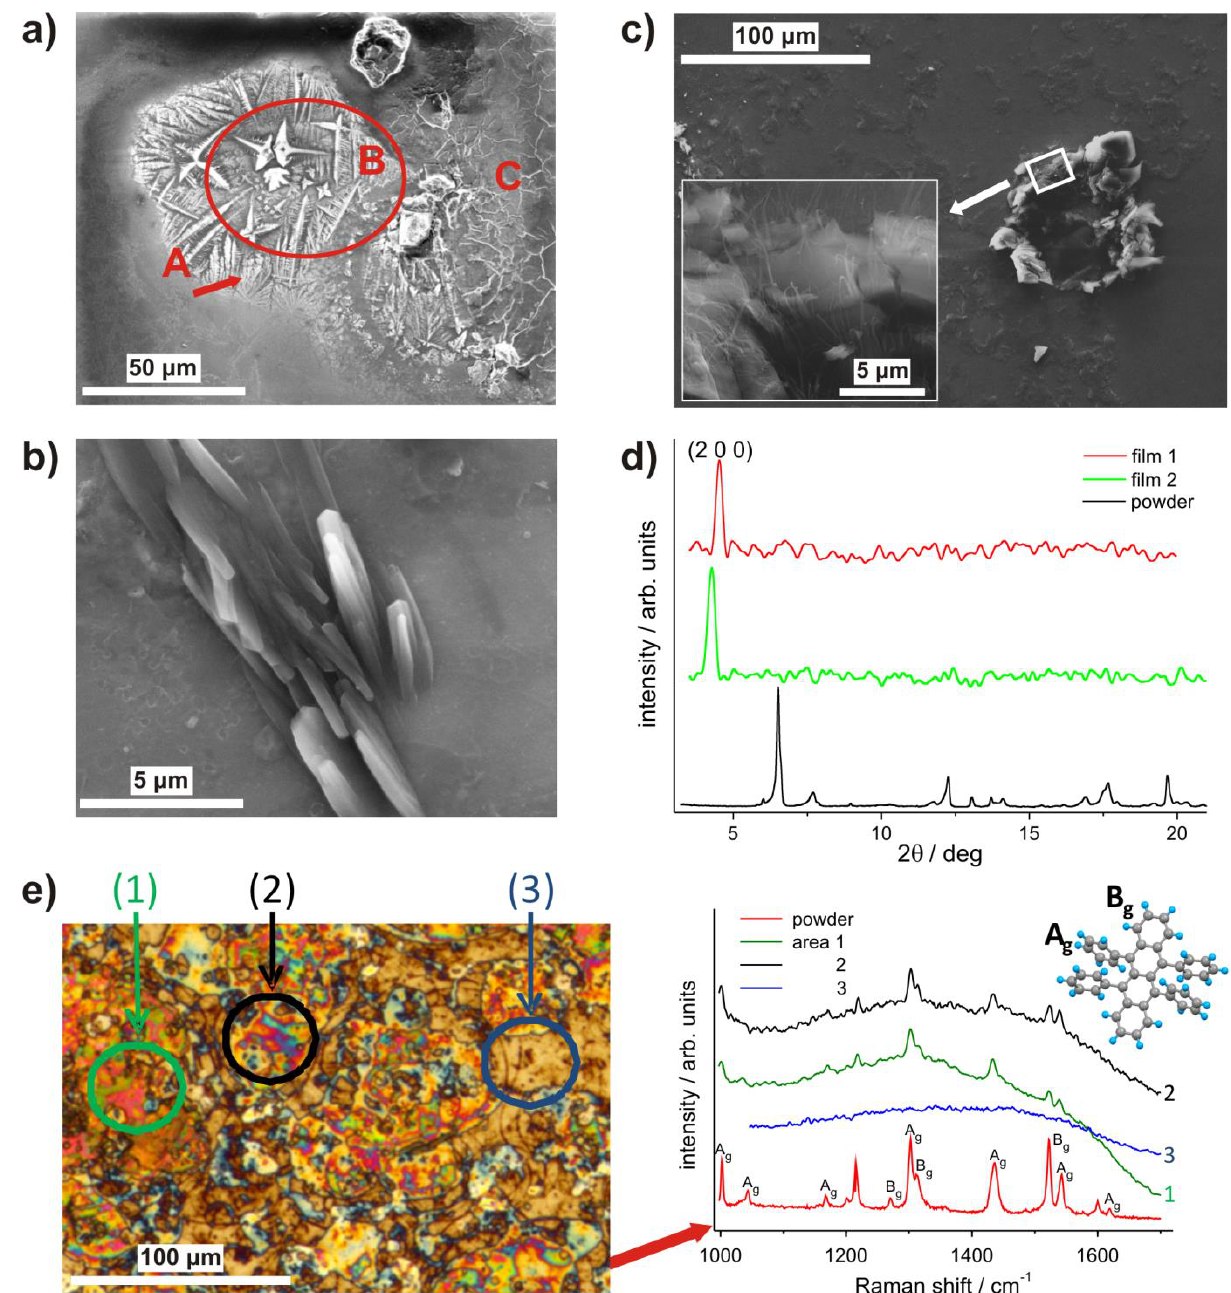
Figure 4. Structural characterization of the rubrene films deposited under conditions as in Figure 3. ( a ) SEM inspection reveals well developed spherulitic structures (A) and large orthorhombic (B) and flat crystallites (C); ( b ) ensemble of columnar crystals growing from amorphous base; ( c ) crater in the base layer surrounded by plate-like crystals forming growth platforms for nanowires (inset); ( d ) comparison of the GIXD (film 1 and 2) and XRD patterns (powder); ( e ) optical micrograph and Raman spectra recorded for areas (1–3) of the film surface and the baseline corrected spectrum of rubrene powder